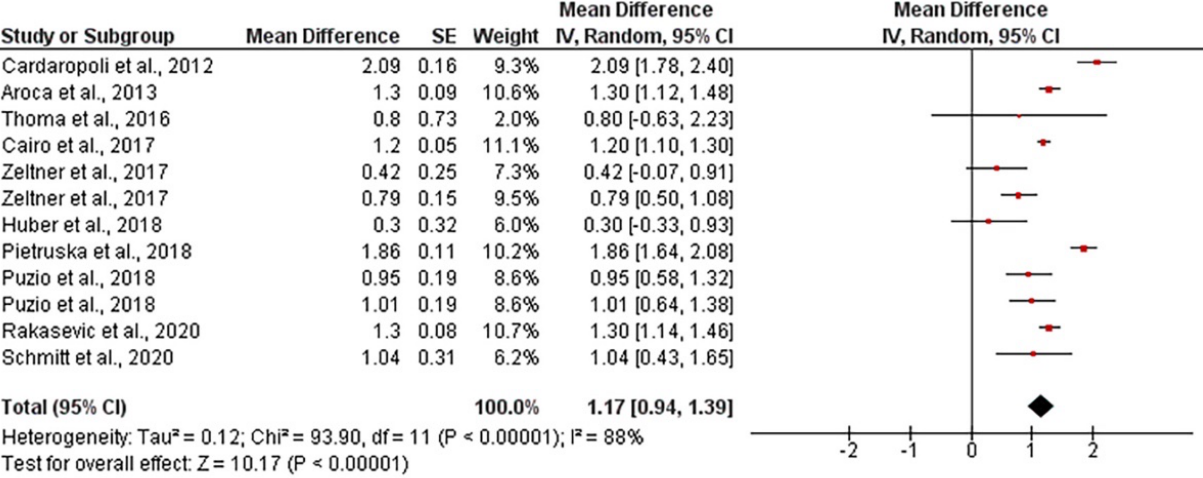
Figure 8. Forest plot for keratinized mucosa width gain. Test (collagen matrix) vs. control (autogenous connective tissue) groups. The weighted mean is presented at CI 95%. Heterogeneity was determined using Higgins (I 2 ). A random-effects model was applied. Statistical significance was p = 0.04.